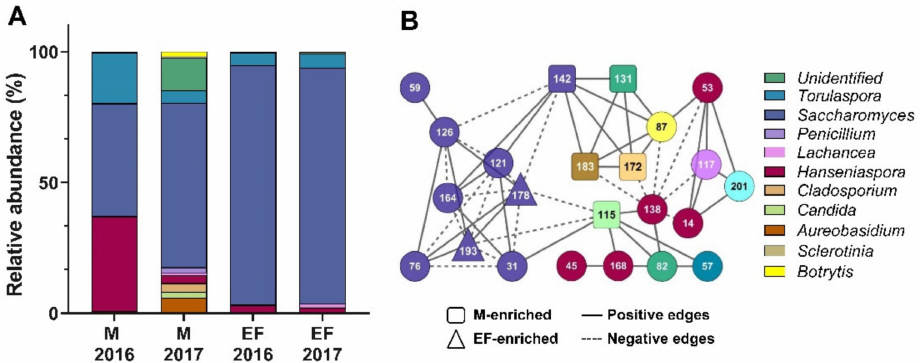
Figure 1. Fungal assemblages of unfermented and end of fermentation stages. ( A ) Average relative abundances of genera from unfermented (M) and end of fermentation (EF) samples ( > 0.1% of relative abundance in at least one sample) based on massive sequencing of Operational Taxonomical Units (OTUs) in triplicates. ( B ) Fungal interaction network of M and EF samples from both